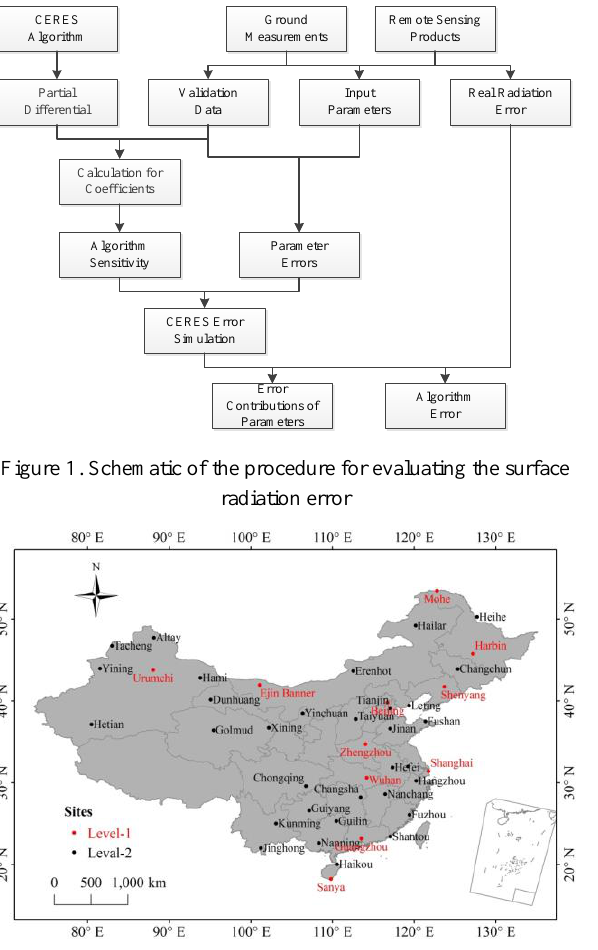
Figure 2. Distribution of surface radiation sites in